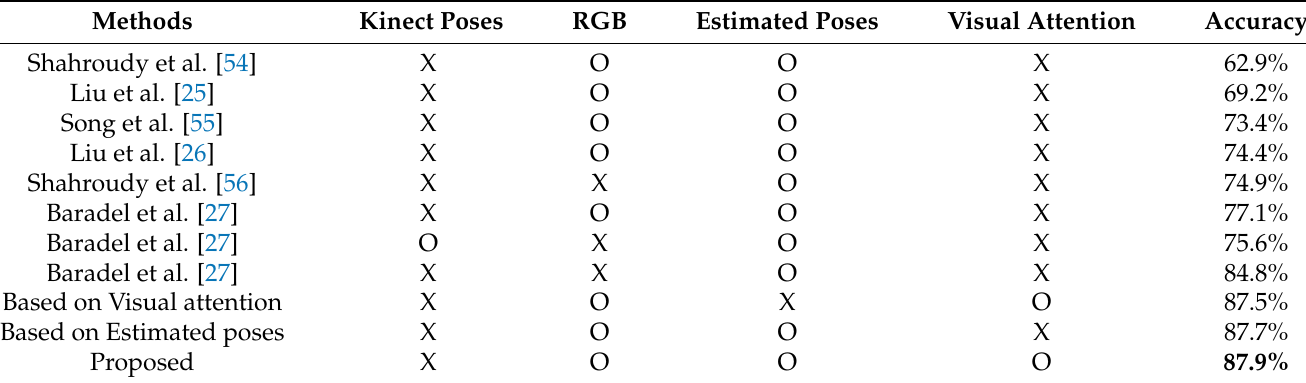
Table 3. Experimental results with the NTU